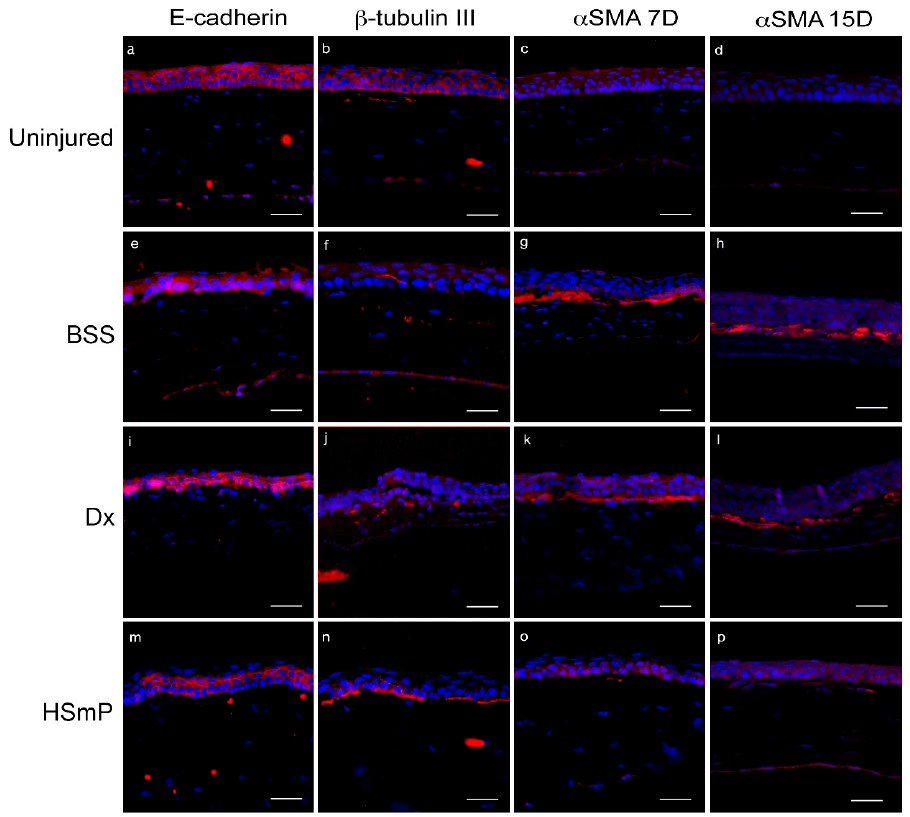
Figure 4. Expression of epithelial, myofibroblast and innervation markers. Column 1: Epithelium cytoarchitecture 7 days after injury. Uninjured corneas showed a structured epithelium with E-cadherin staining restricted to the periphery of the cells, forming a typical network pattern ( a ). The BSS group ( e ) presented irregularities in the epithelium and diffuse E-cadherin staining. Cor- neas treated with Dx exhibited E-cadherin staining at the superficial layers of the epithelium but it was absent from basal layers ( i ). HSmP-treated corneas ( m ) presented a correctly stratified epithe- lium with normal E-cadherin staining. Column 2: Intraepithelial nerve regeneration 7 days after injury in cross-section. The subbasal plexus is easily recognizable in uninjured corneas at the bot- tom of basal epithelial cells ( b ). Numerous nerve terminals rose to the epithelial surface. The gen-